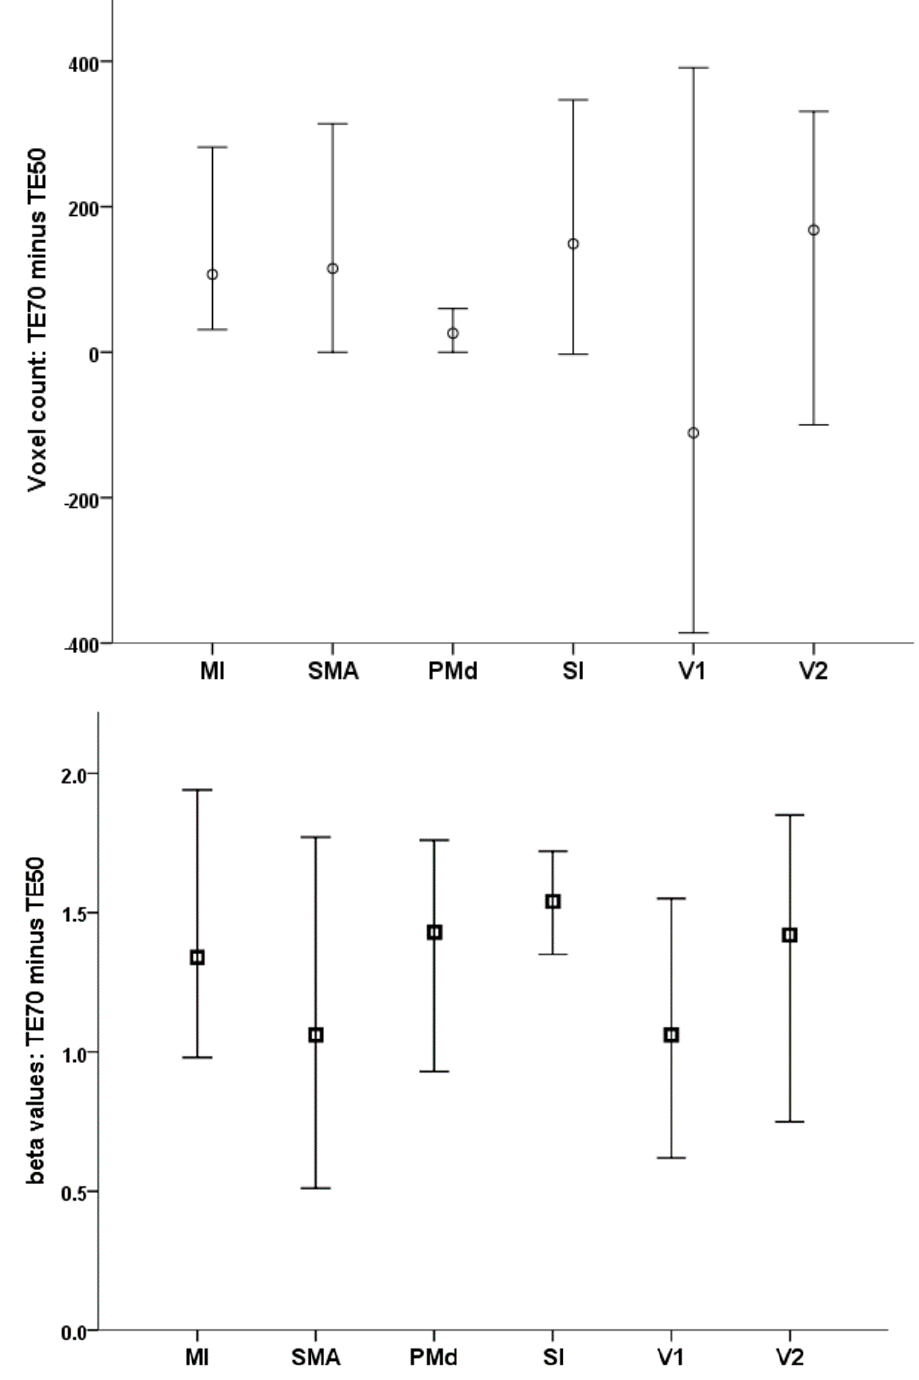
Figure 4. Difference in voxel number ( upper panel ) and in peak beta values ( lower panel ) in the 6 brain regions where significant task-related activity was found in the present study. Vertical bars represent 95% confidence intervals.